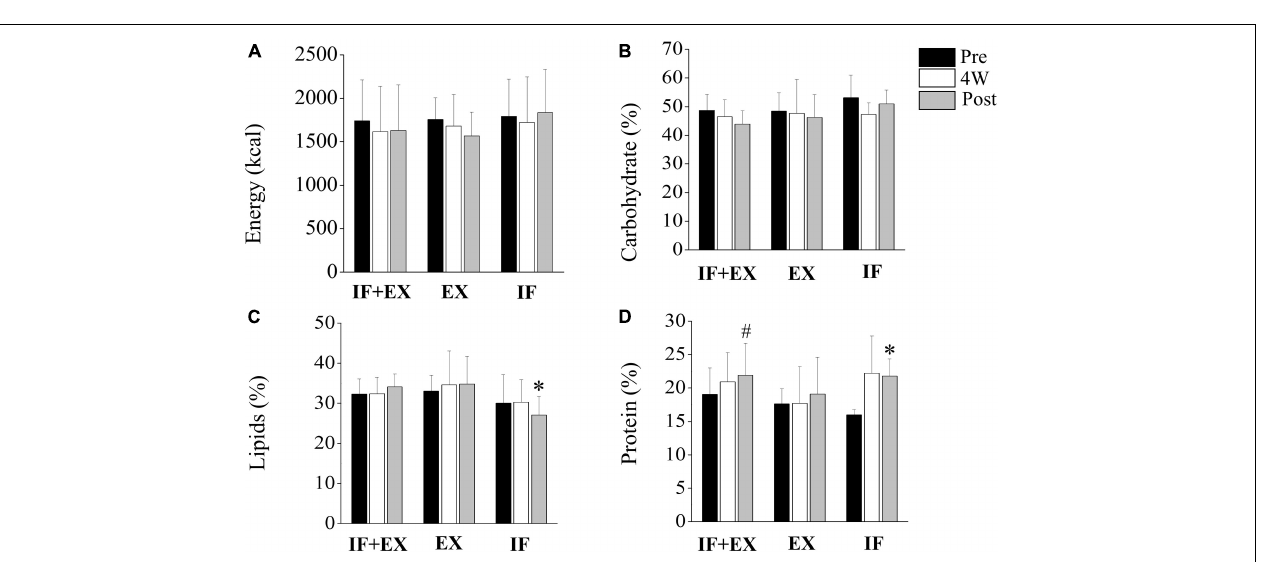
FIGURE 2 | Scatter Plot to body composition pre- and post-intervention. (A) Body fat (%); (B) Fat-free mass (%). IF + EX, intermittent fasting group in conjunction with exercise ( n = 15); EX, exercise group ( n = 11); IF, intermittent fasting group ( n = 9); *Differences within group, post vs pre ( p < 0.05), by ANOVA two-way repeated measures mixed model, Sidak post hoc .